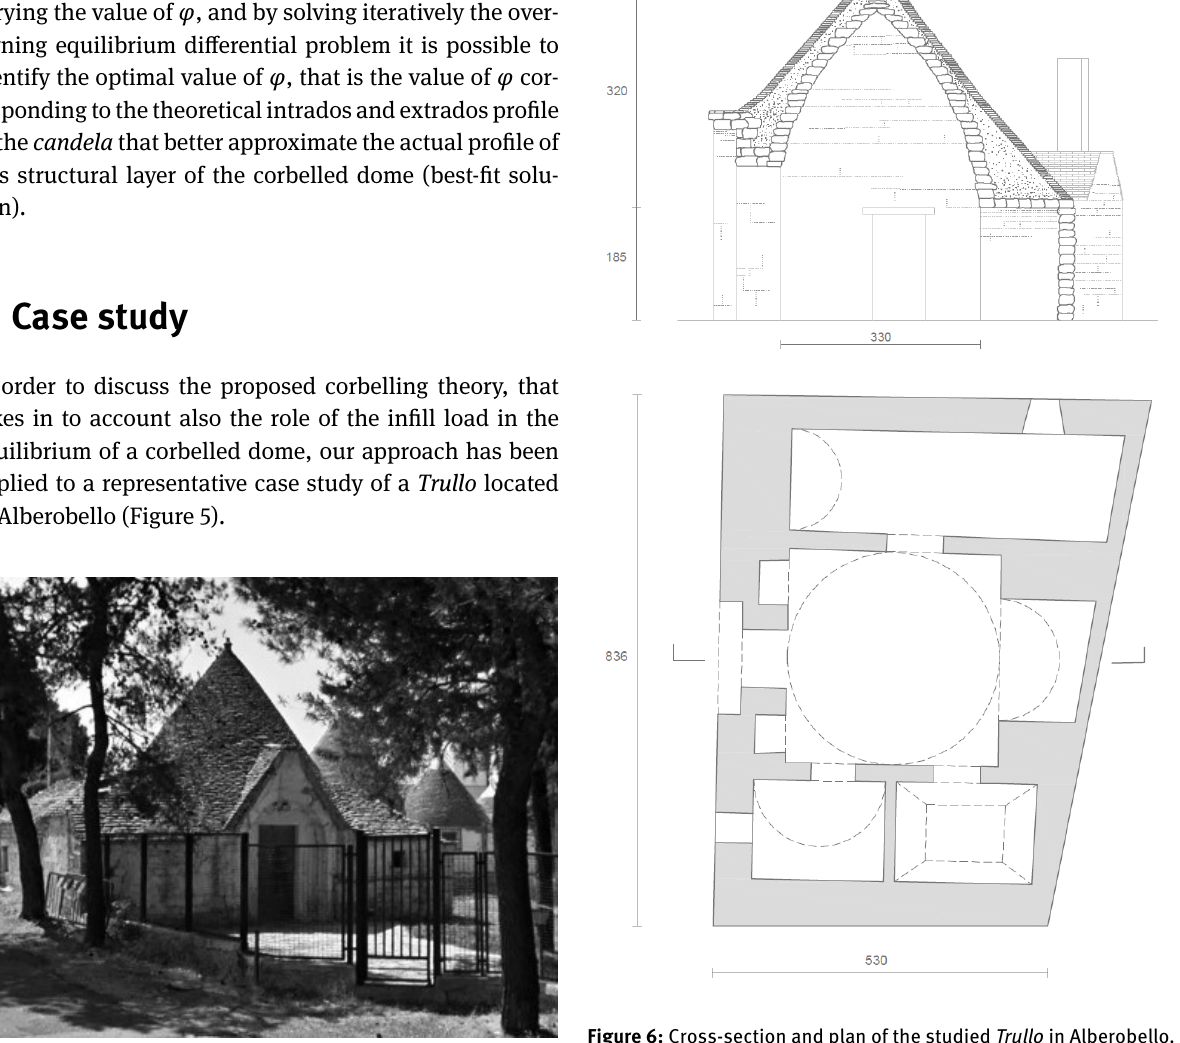
Figure 5: The case study: a Trullo in Alberobello.